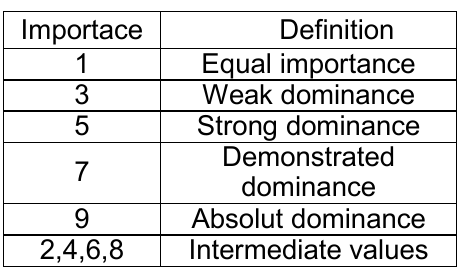
Table 1 – Saaty’s fundamental scale Таблица 1 – Фундаментальная шкала Саати Tabela 1 – Sartijeva fundamentalna